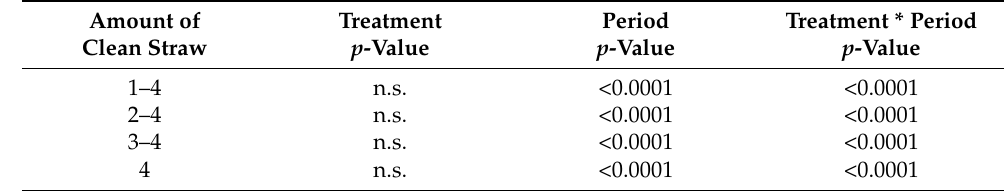
Table 5. Final models evaluating treatment effect on available clean straw on the pen floor, including Treatment, Period and the interaction between Treatment and Period (Treatment *